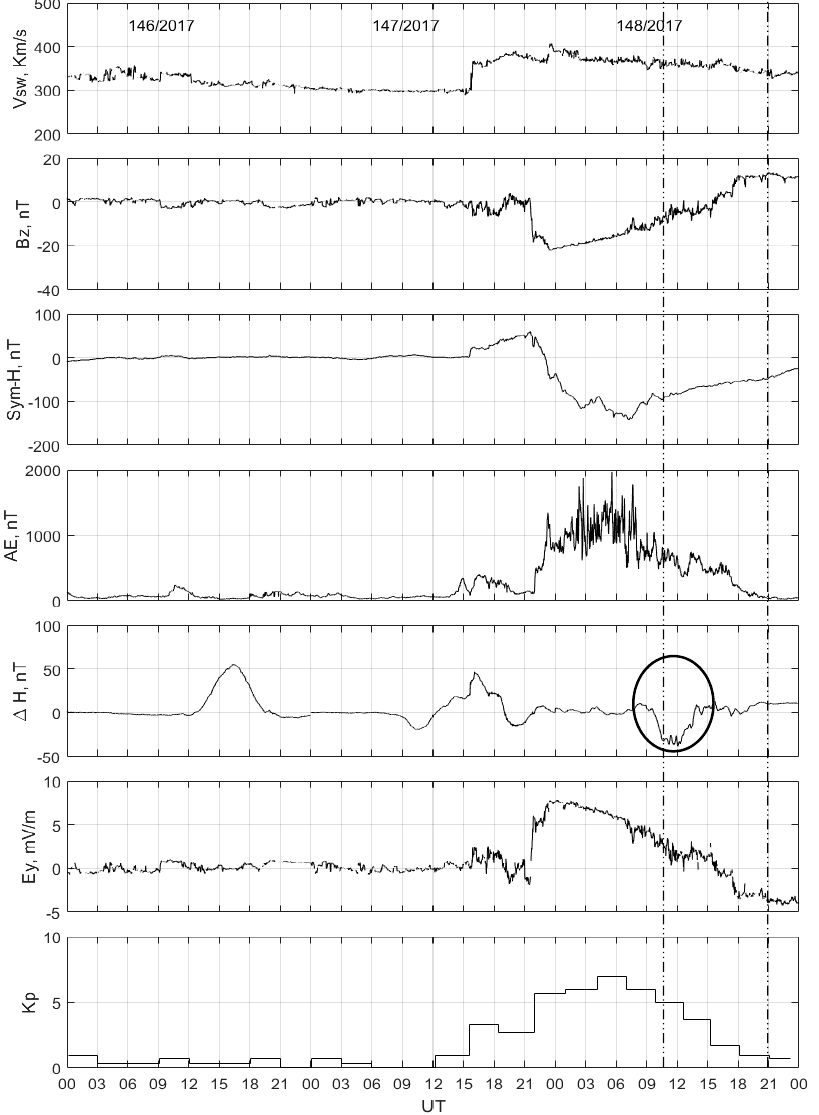
Figure 2. Geophysical and geomagnetic conditions during 26–28 May 2017. From top to bottom: solar wind speed (Vsw), the Bz component of the magnetic field of interplanetary magnetic field (IMF), the symmetric magnetic field strength (Sym-H) index, the auroral electrojet (AE) index, ∆ H (Belem − Petrolina) , interplanetary east–west electric field (Ey, positive to east), and the Kp magnetic index. The dashed lines represent the time period when different features of TIDs were observed. The black circle (on the ∆ H panel) highlights the ∆ H downward plasma drift on 28 May 2017.